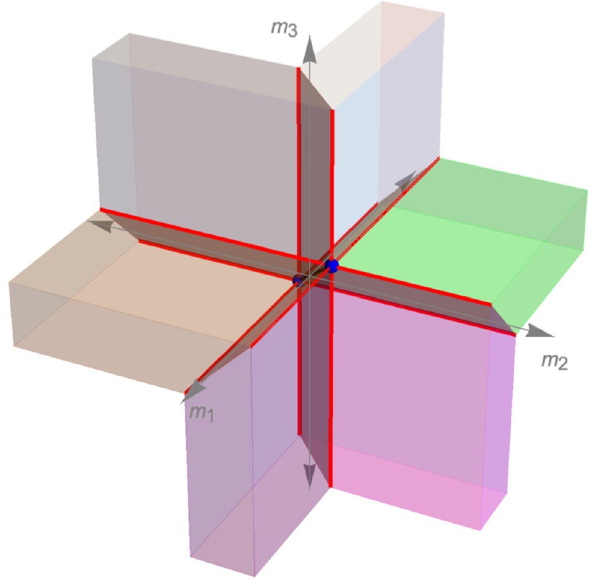
Fig. 13 The three-dimensional phase diagram of SU ( N ) k + p ψ 1 + q ψ 2 + ( F − p − q )ψ 3 with 0 ≤ k < ( p + q ) − F / 2. ˆ σ c by the region in gray, while ˆ σ c